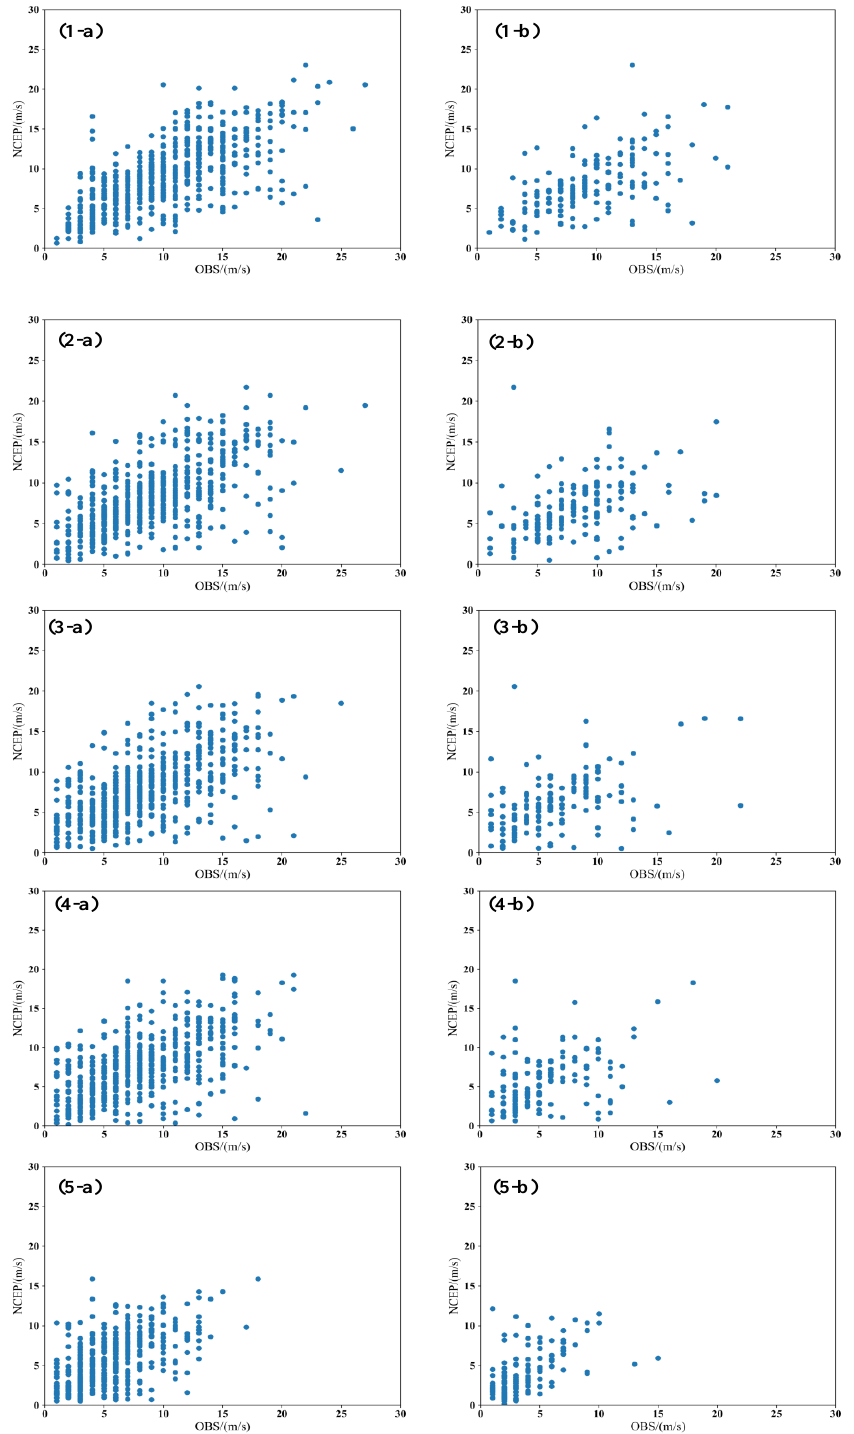
Figure 8. Correlation of the wind speed between the observations and the NCEP/FNL reanalysis data at ( 1 ) 850, ( 2 ) 900, ( 3 ) 925, ( 4 ) 950, and ( 5 ) 1000 hPa during the ( a ) clean days and ( b ) polluted